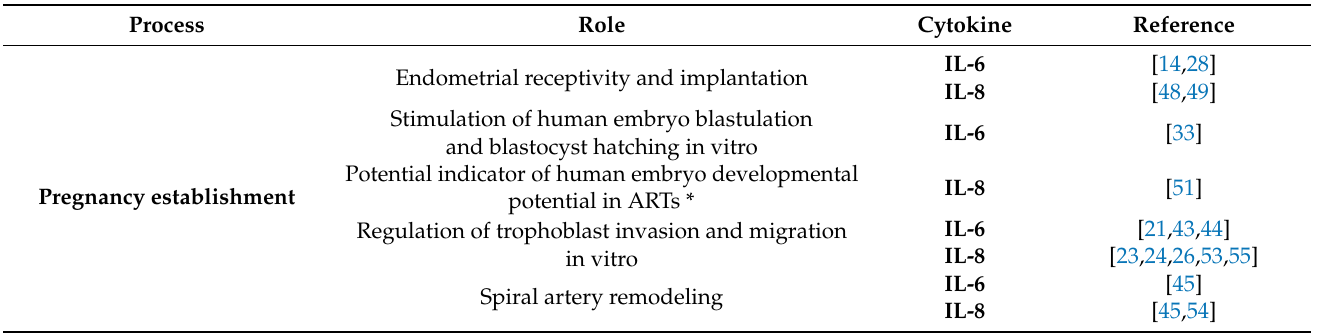
Table 1. Involvement of IL-6 and IL-8 in a healthy